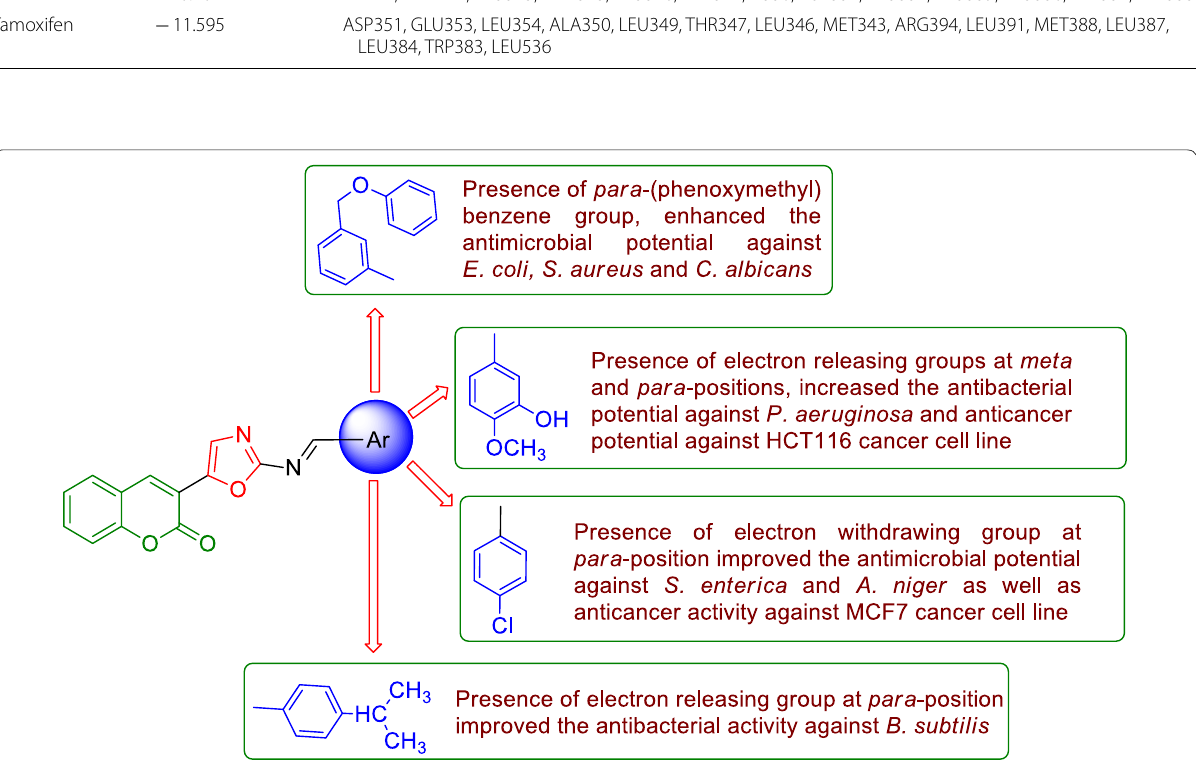
Fig. 10 Structure activity relationship of synthesized